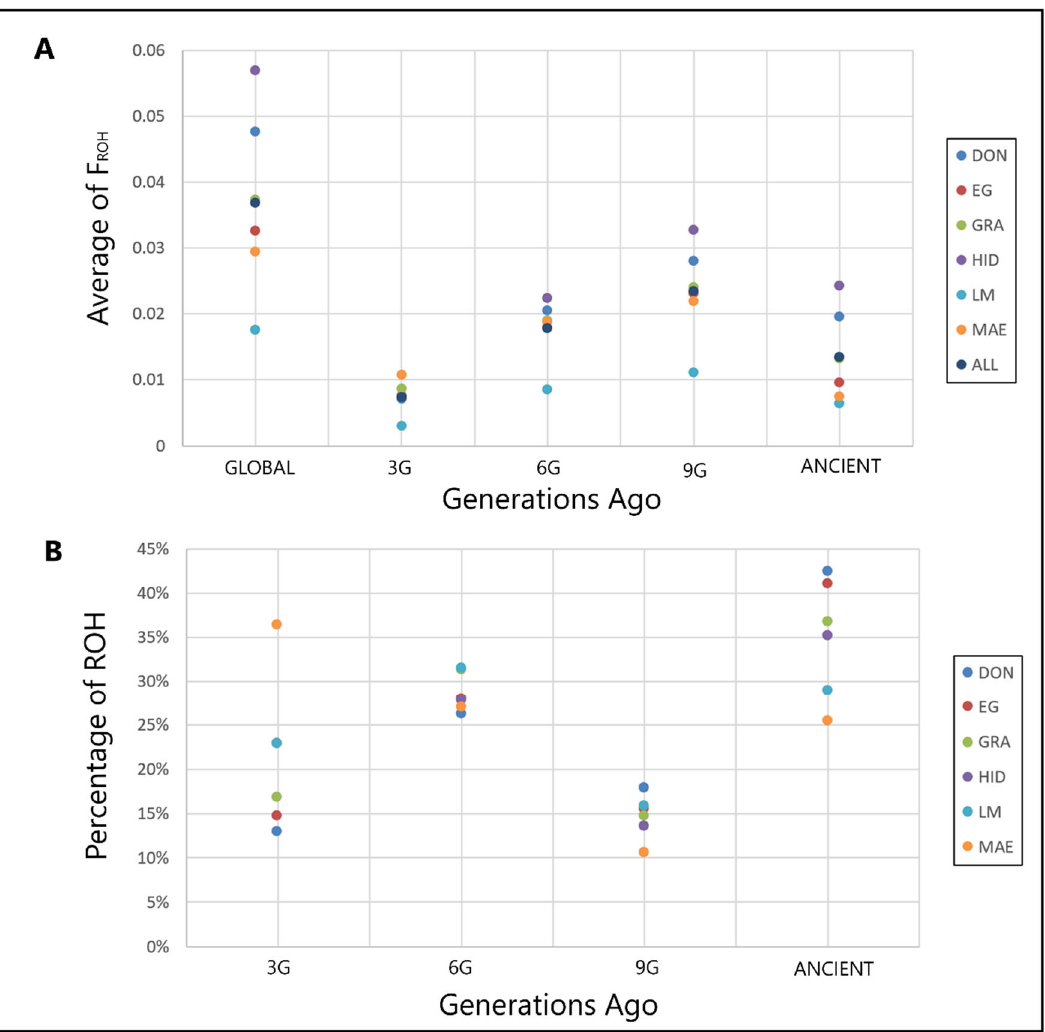
Figure 1. ( A ) Average of F ROH of the historical genetic lines of the Spanish Merino. F ROH : genomic inbreeding coefficients; GLOBAL: global F ROH ; 3G: F ROH of 3 generations ago; 6G: F ROH of 6 generations ago; 9G: F ROH of 9 generations ago; ANCIENT: F ROH of over 9 generations ago. ( B ) Percentage of Run of Homozygosity (ROH) by class. ROH: Run of Homozygosity; 3G: Percentage of ROH 3 generations ago; 6G: Percentage of ROH 6 generations ago; 9G: Percentage of ROH 9 generations ago; ANCIENT: Percentage of ROH over 9 generations ago. Historical lines: DON (Donoso), EG (Egea), GRA (Granda), HID (Hidalgo), MAE (Maesso), LM (López ‐ Montenegro), ALL (all of the genetic lines together).